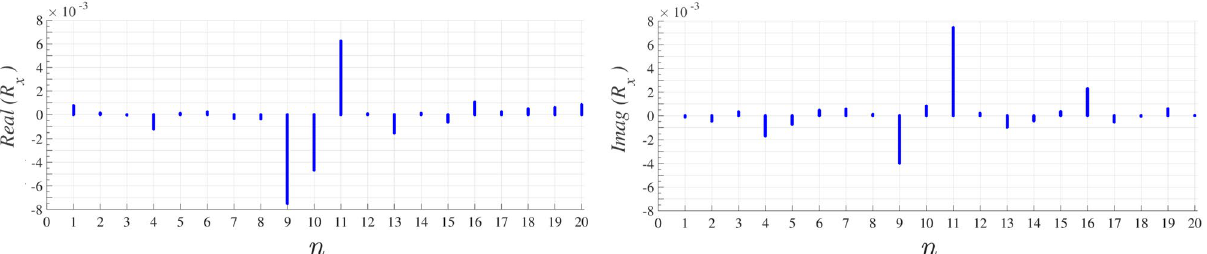
Figure 8. Real and imaginary part of evaluated R x at each discreted value of ϕ